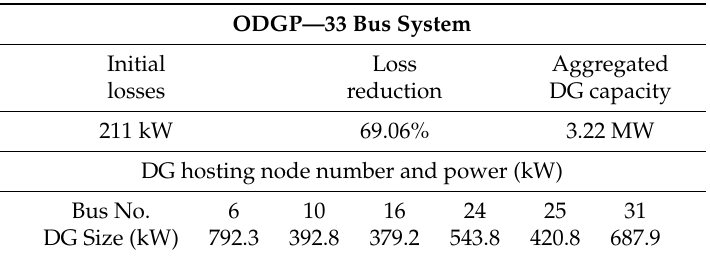
Table 2. ODGP results for 33 bus system.